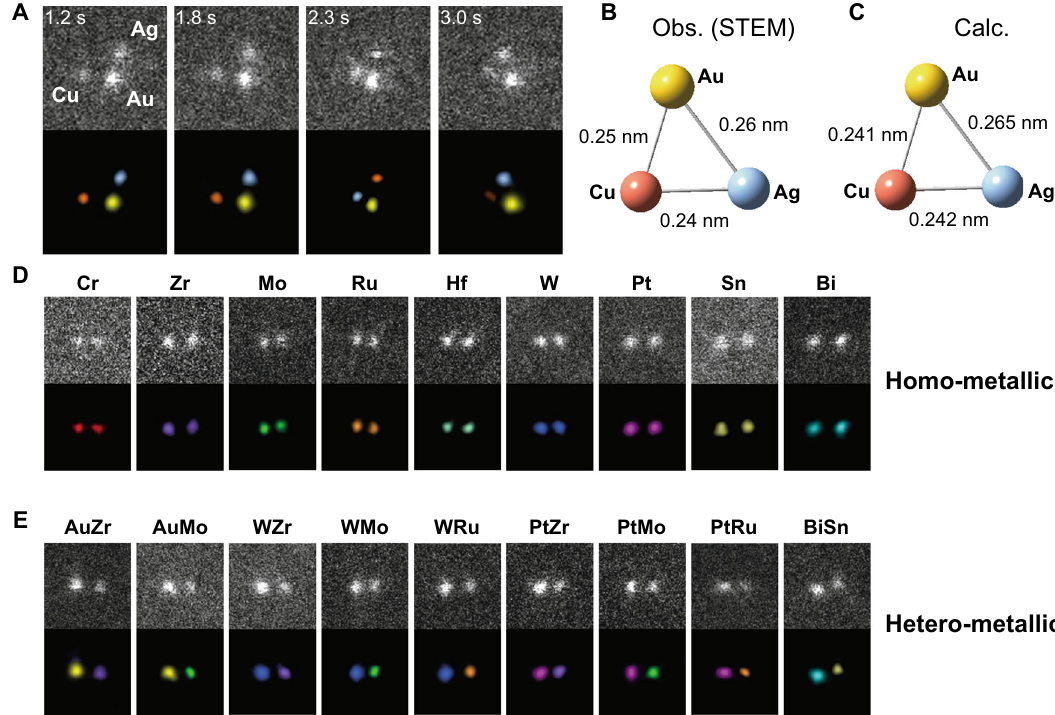
Fig. 5 STEM observation of the Au – Ag – Cu trimer and various dimers. A ADF-STEM snapshot images of the Au – Ag – Cu trimer. The lower images are created by coloring the upper images. The actual size of one side of each frame is 1.22 nm. B The structure of Au – Ag – Cu trimer with averaged bond distances of the snapshots in the panel ( A ). C The optimized structure of Au – Ag – Cu trimer in vacuum by the calculation. D ADF-STEM images of homometallic dimers (Cr 2 , Zr 2 , Mo 2 , Ru 2 , Hf 2 , W 2 , Pt 2 , Sn 2 , and Bi 2 ). E ADF-STEM images of the heterometallic dimers (AuZr, AuMo, WZr, WMo, WRu, PtZr, PtMo, PtRu, and BiSn). For ( D , E ), the upper images show the original data, whereas the lower images show the ones colored by the element based on the electron scattering intensity